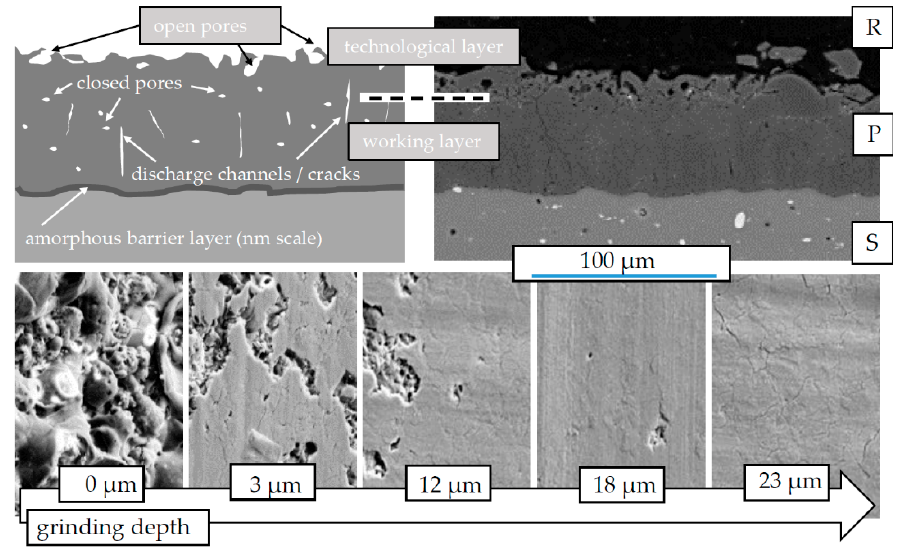
Figure 10. Morphology of a PEO coating produced on AlMgSi1 alloy, schematic representation and micrographs of a cross section (R – Embedding Resin, P – PEO-Layer, S – Substrate), as well as several top views with increasing grinding depth, which show an increasingly compact layer structure [19].